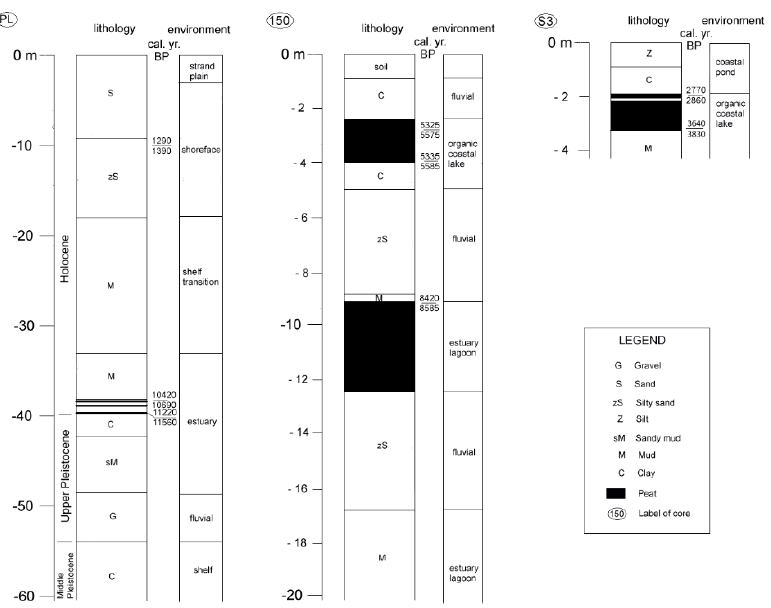
Figure 7. Lithological/environmental scheme of some boreholes executed in the Tiber delta area. PL and 150 are rotating boreholes; S3 is percussion boreholes. PL is modified after [68]; S3 is modified after